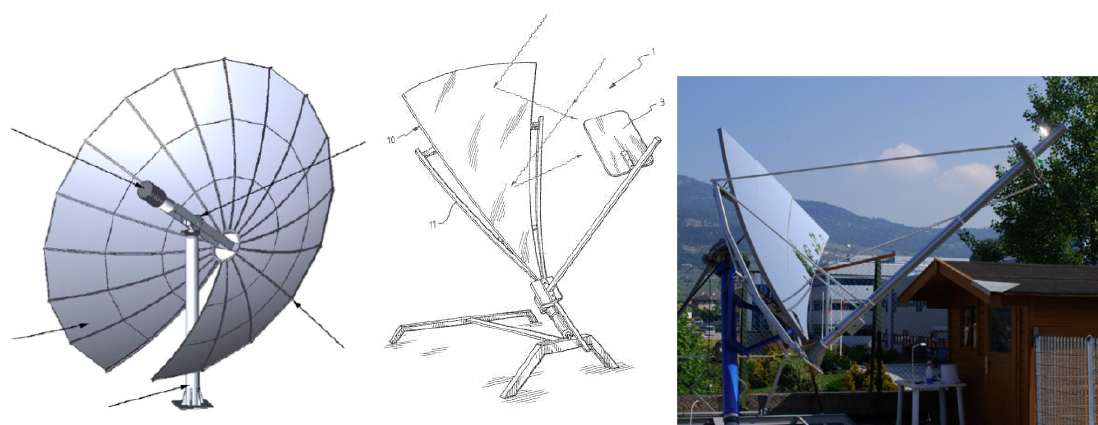
Figure 3. Schematic drawing and picture of a parabolic dish [52,53].